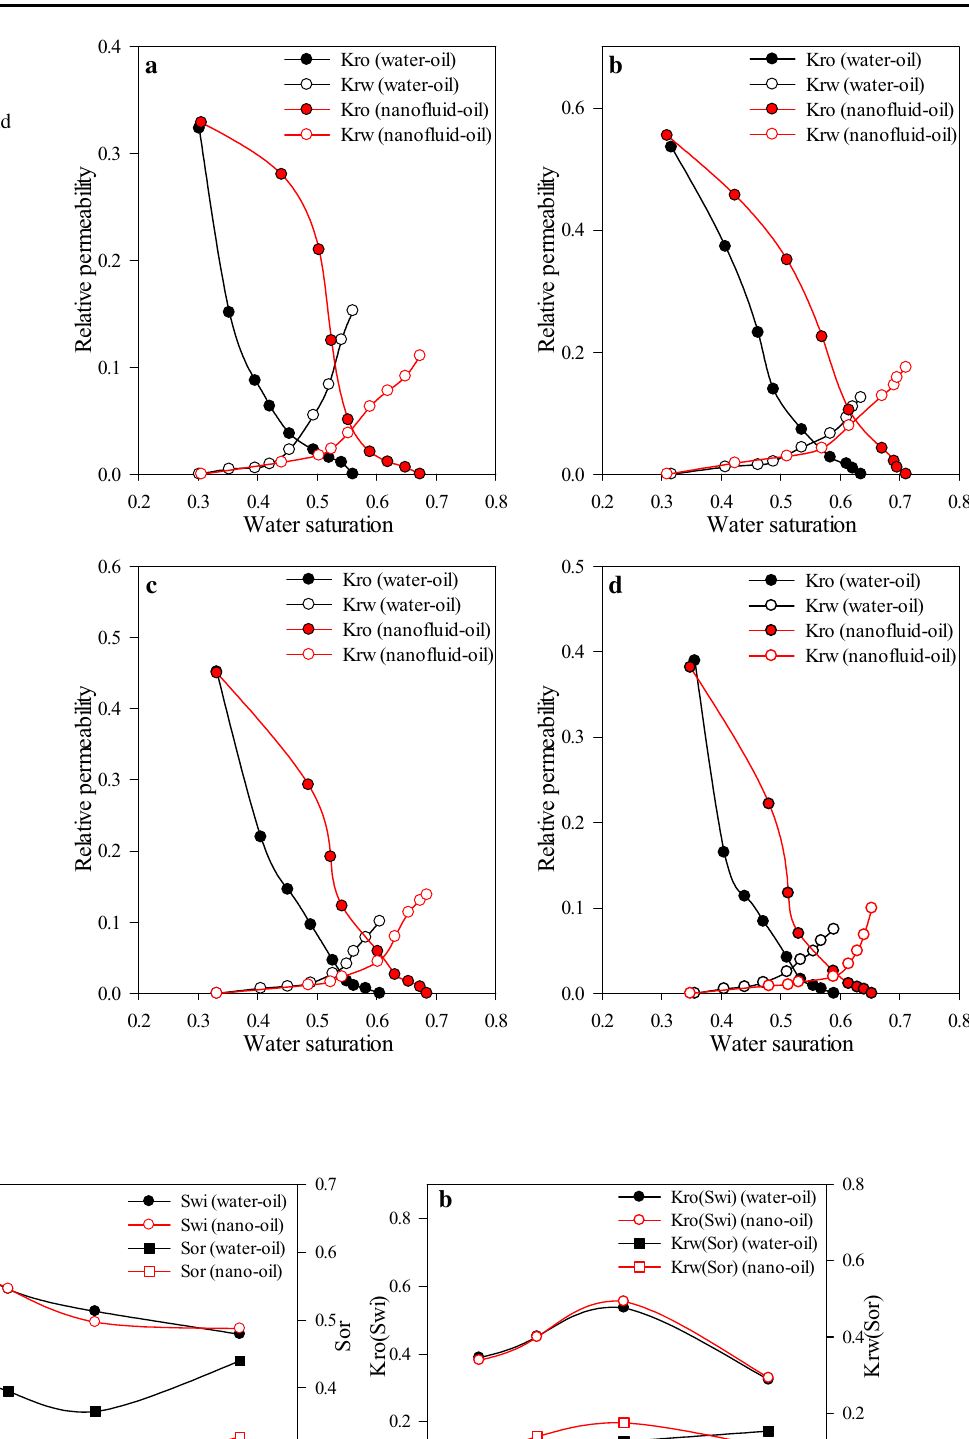
Fig. 11 Comparison of water– oil and nanofluid–oil relative permeability under stress: a 10 MPa, b 5 MPa, c 2 MPa, and d 0.1 MPa